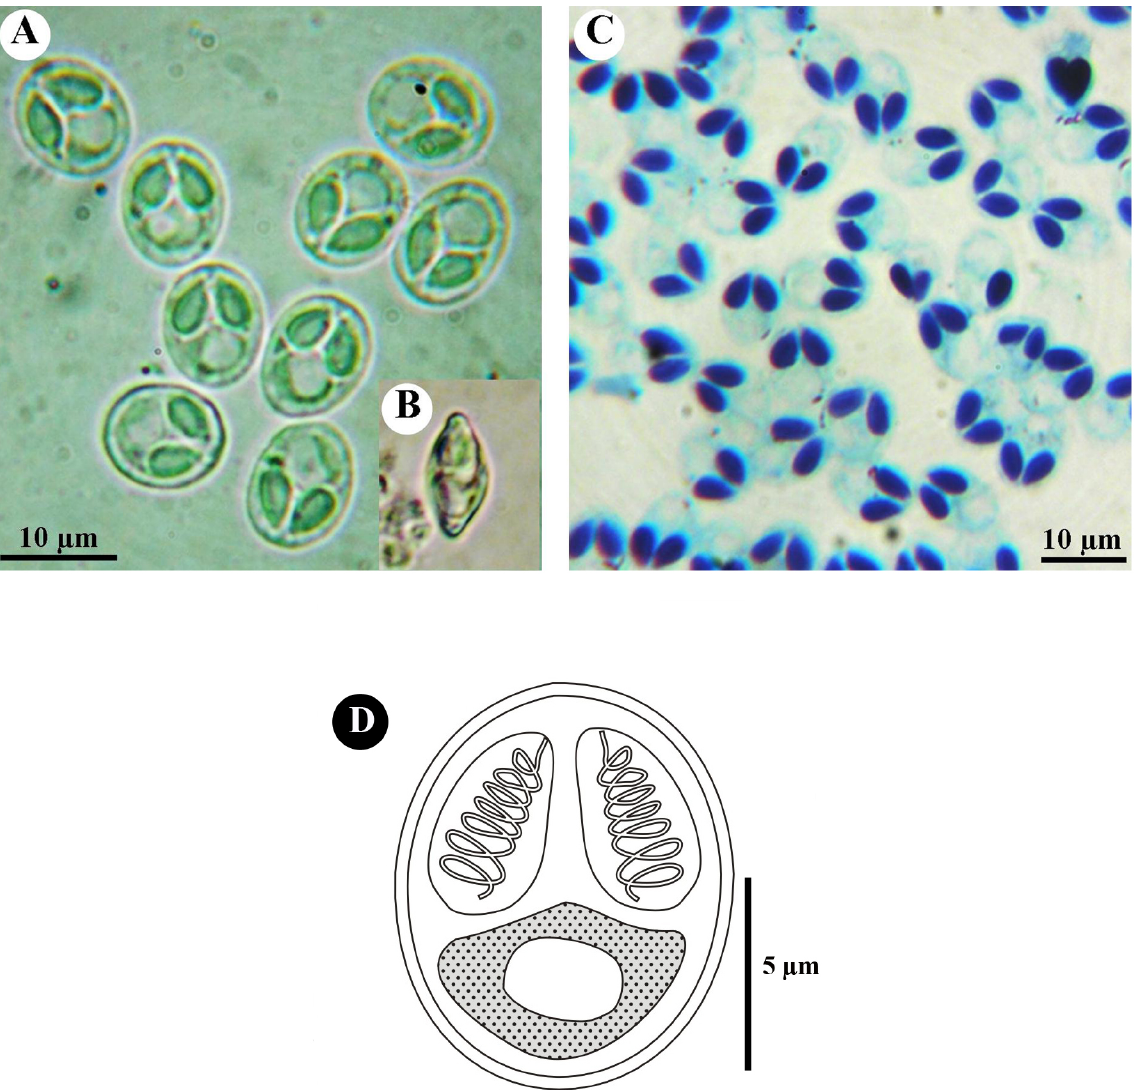
Fig. 1. Photomicrographs of Myxobolus opsaridiumi sp. nov. infecting skin, muscle and spleen of Opsaridium ubangiensis (Pellegrin, 1901). A . Fresh myxospores in frontal view. B . Fresh myxospore in lateral view. C . Giemsa-stained myxospores. D . Diagrammatic drawing of a mature